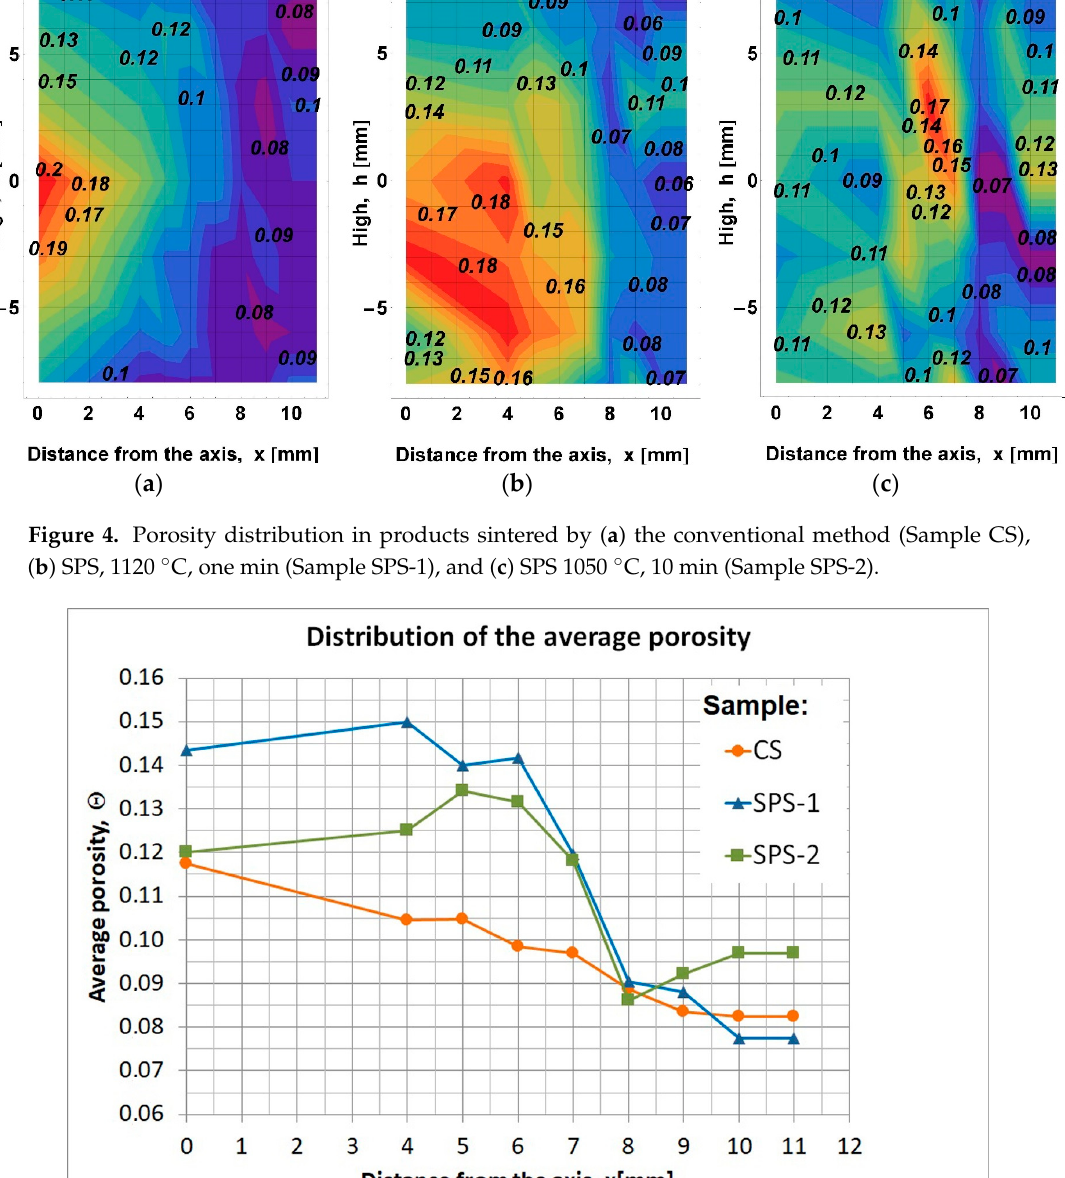
Figure 5. Distribution of the average porosity as a function of the distance from the axis of products sintered by various methods.